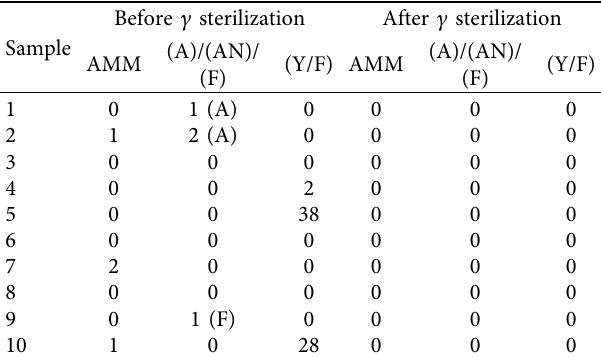
Table 5: Colony forming units of microorganisms detected on PCL 25kGy samples microfilaments before and after sterilization with gamma